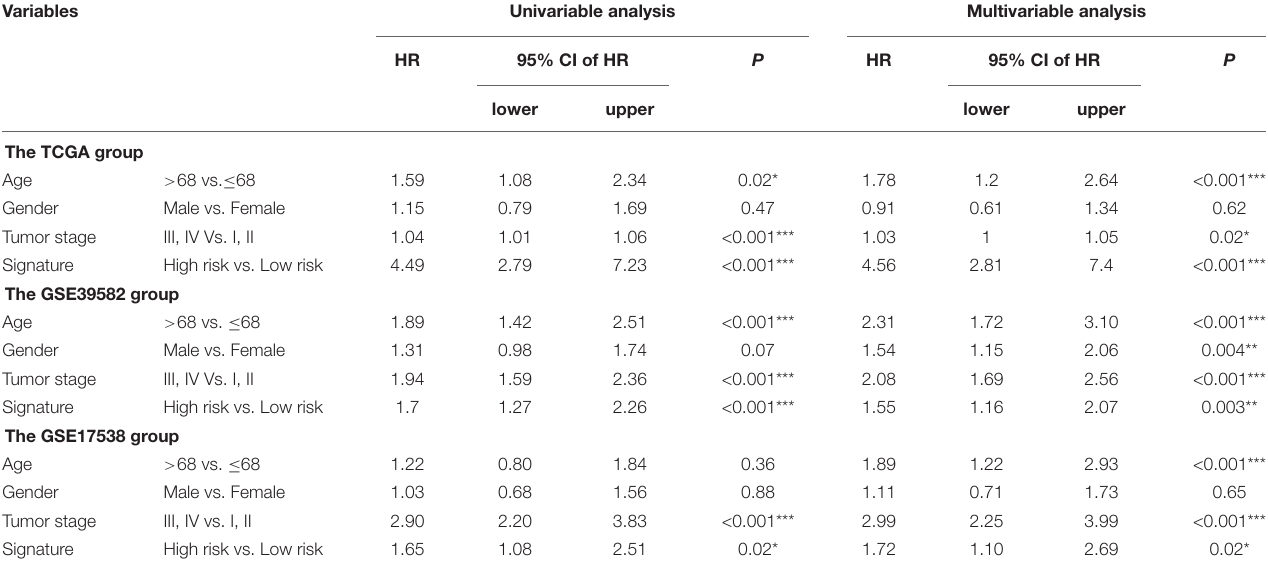
TABLE 4 | Cox regression analysis of the IRG signature with survival. Variables